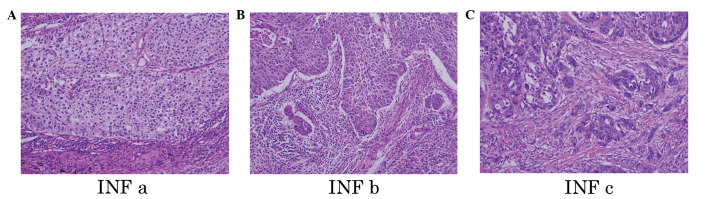
Microscopic findings of lung squamous cell carcinoma (hematoxylin and eosin staining). Tumor infiltrative patterns (INF) at the invasive front are classified into three groups: (A) INFa, cancer nests show an expansion in growth and a distinct border with the surrounding tissue; (B) INFb, the manner of growth and invasive pattern are between those of INFa and INFc; and (C) INFc, cancer nests show infiltrative growth and the borderline with the surrounding tissue is unclear.